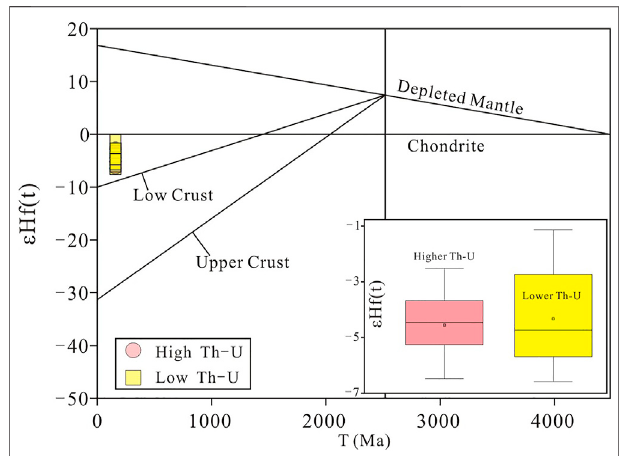
FIGURE 9 | Age vs ε Hf(t) plots for the Jianfengling granite samples.